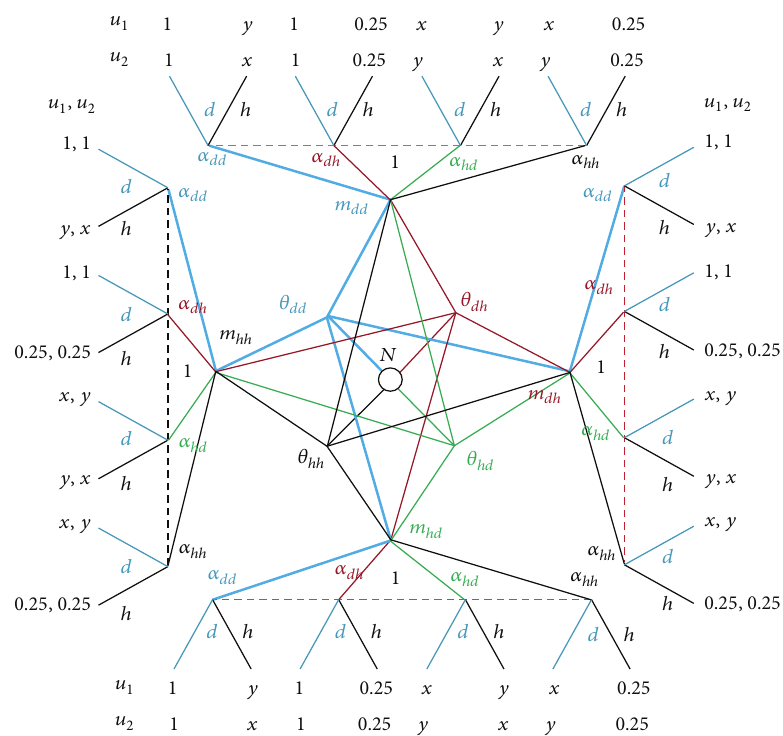
Figure 2: Conflict game with nonbinding